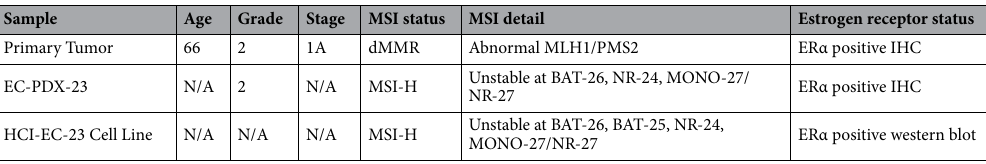
Table 1. Characteristics of HCI-EC-23 primary tumor and derived models. MSI microsatellite instability, dMMR defective mismatch repair, MSI-H microsatellite instable high, IHC immunohistochemistry, N/A not